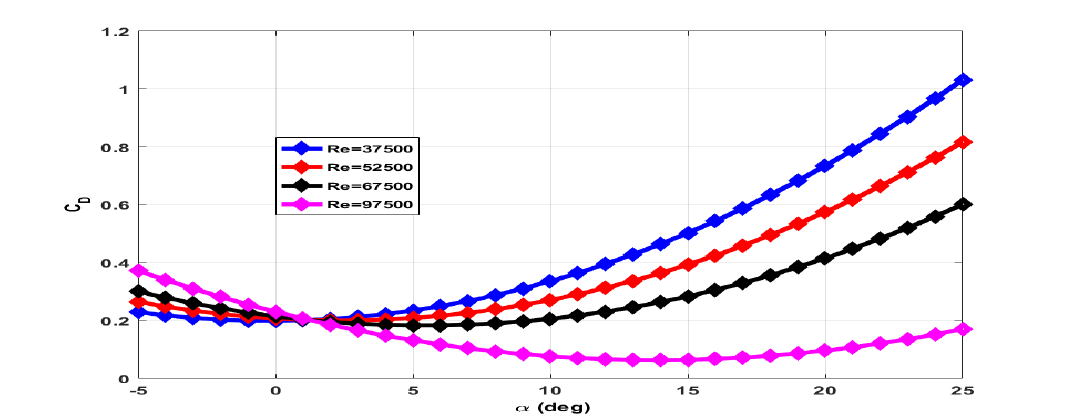
Figure 10. Coefficient of drag at − 25 ◦ elevator deflection and zero propeller